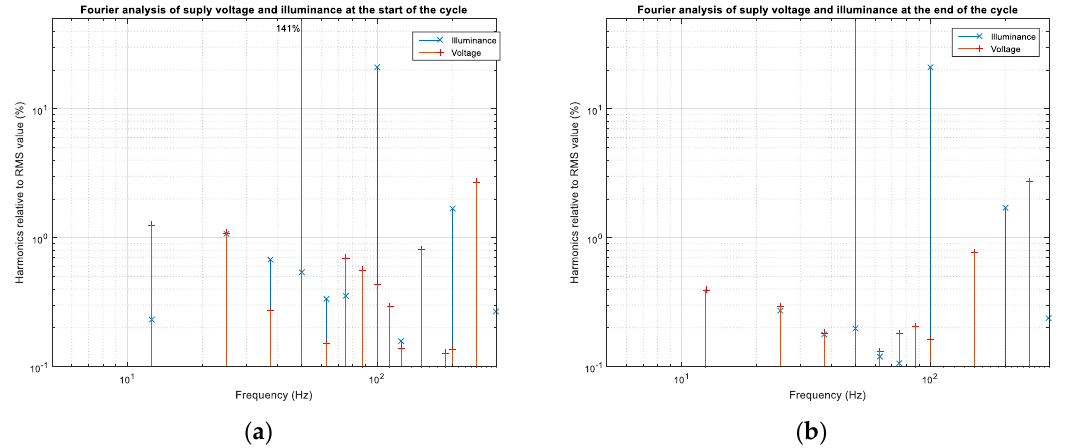
Figure 4. Harmonic analysis of modulated supply voltage and illuminance in an office ( a ) At the beginning and ( b ) At the end of the start-up cycle.